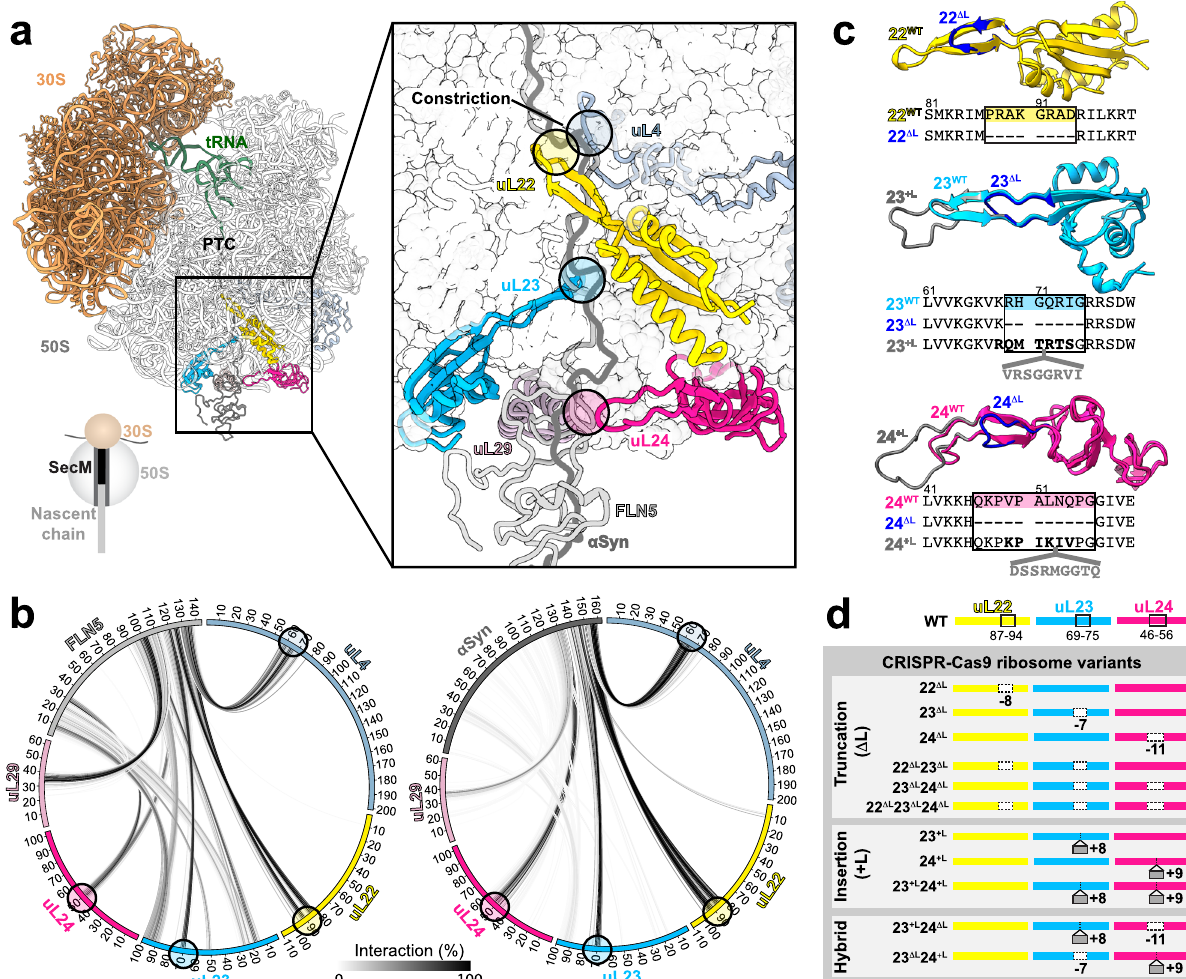
Fig. 1 Ribosomal proteins at the exit tunnel and their structural modi fi cation by CRISPR-Cas9 gene editing. a Structure of the 70S E. coli ribosome highlighting the exit tunnel (boxed). (inset) A magni fi ed view of the loops from ribosomal proteins uL4, uL22, uL23 and uL24 that protrude into the tunnel and make contacts with FLN5 (grey) and α -synuclein (dark grey) NCs. b Circos plots 87 , showing the interactions formed between the NCs, FLN5 (left) and α -synuclein (right), and ribosomal proteins in the exit tunnel as observed in all-atom molecular dynamics simulations restrained with chemical shifts and residual dipolar couplings 8 from NMR spectroscopy. The greyscale lines connecting NCs and the ribosomal proteins represent the extent (% of total frames) of inter-molecular interactions (see ‘ Methods ’ ). The loops of uL4, uL22, uL23 and uL24 that interact with both FLN5 and α -synuclein NCs are circled. c Structures of uL22, uL23 and uL24 proteins from E. coli (PDB:3JBU) superimposed with models of truncated ( Δ L, blue) and inserted ( + L, grey) tunnel loops, and sequences below. d CRISPR-Cas9 ribosomal mutants that were generated and used in this study. Black rectangles show the loop regions that were modi fi